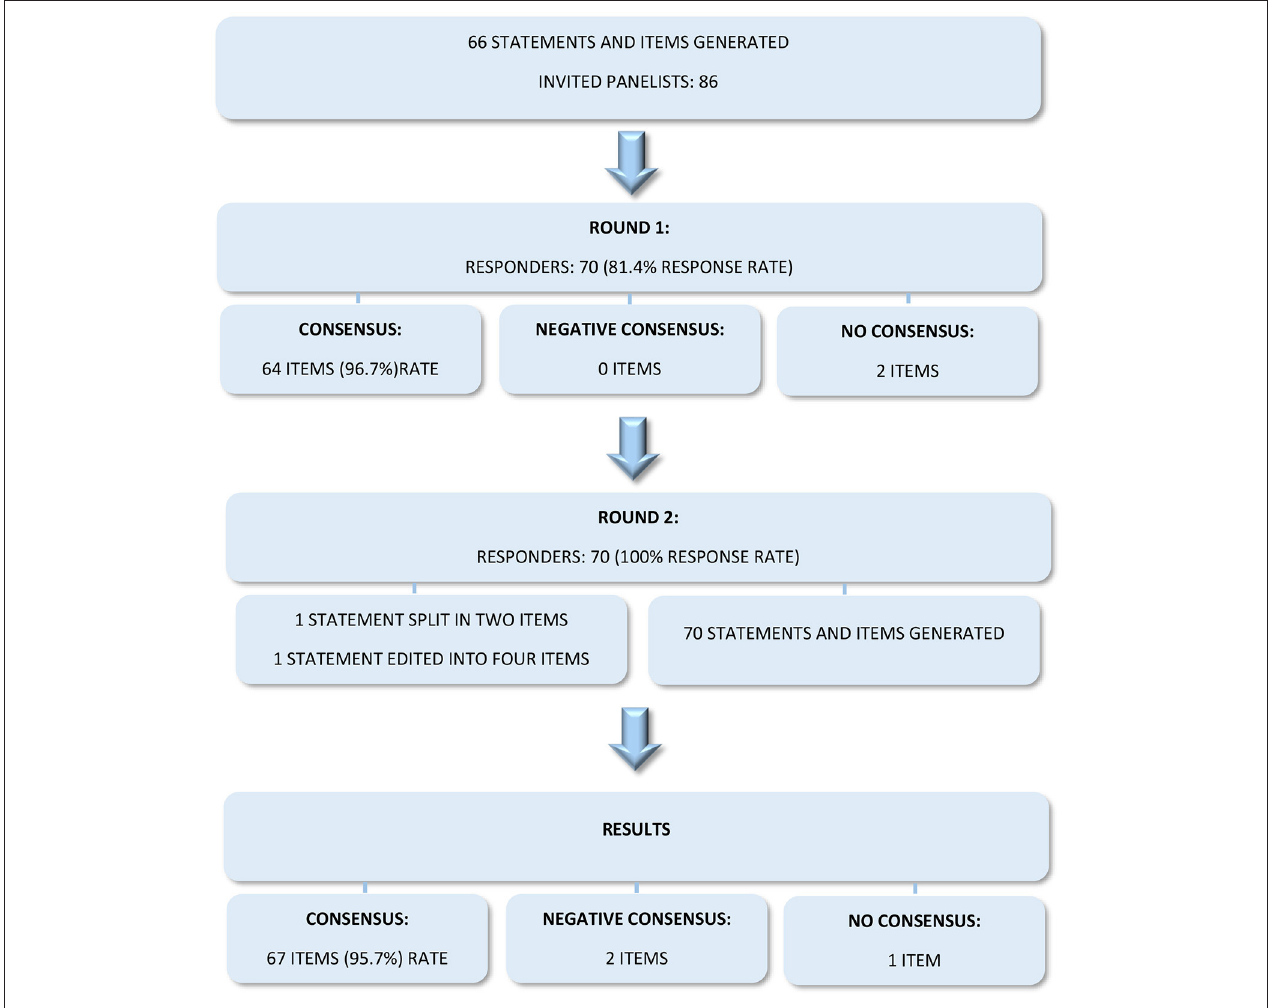
FIGURE 1 | Delphi survey